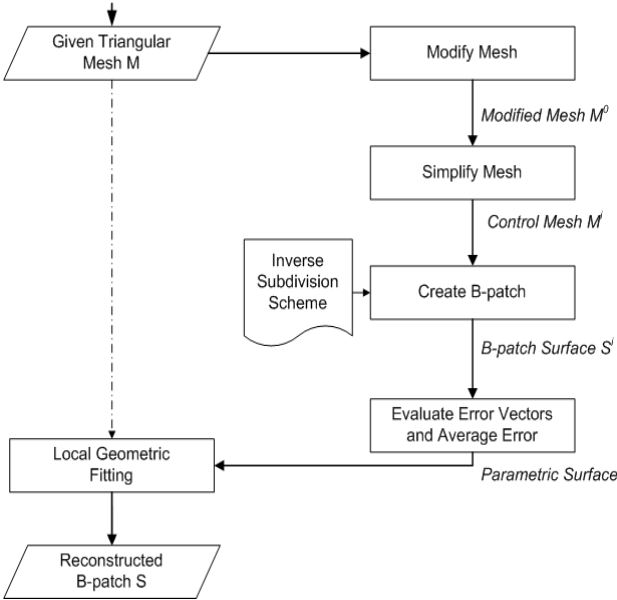
Figure 4. Flow chart of the proposed